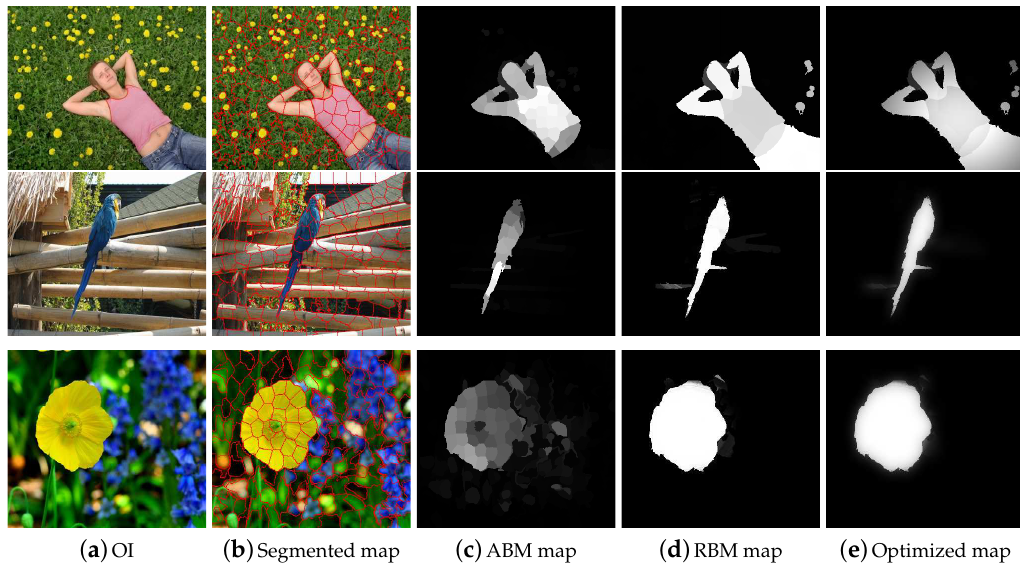
Figure 6. We individually compare the salient region map of each stage of the proposed method by using ASD database [38]. The results are organized as OI, the segmented image, ABM salient region map, enhanced salient region map through RBM, and the final salient region map .